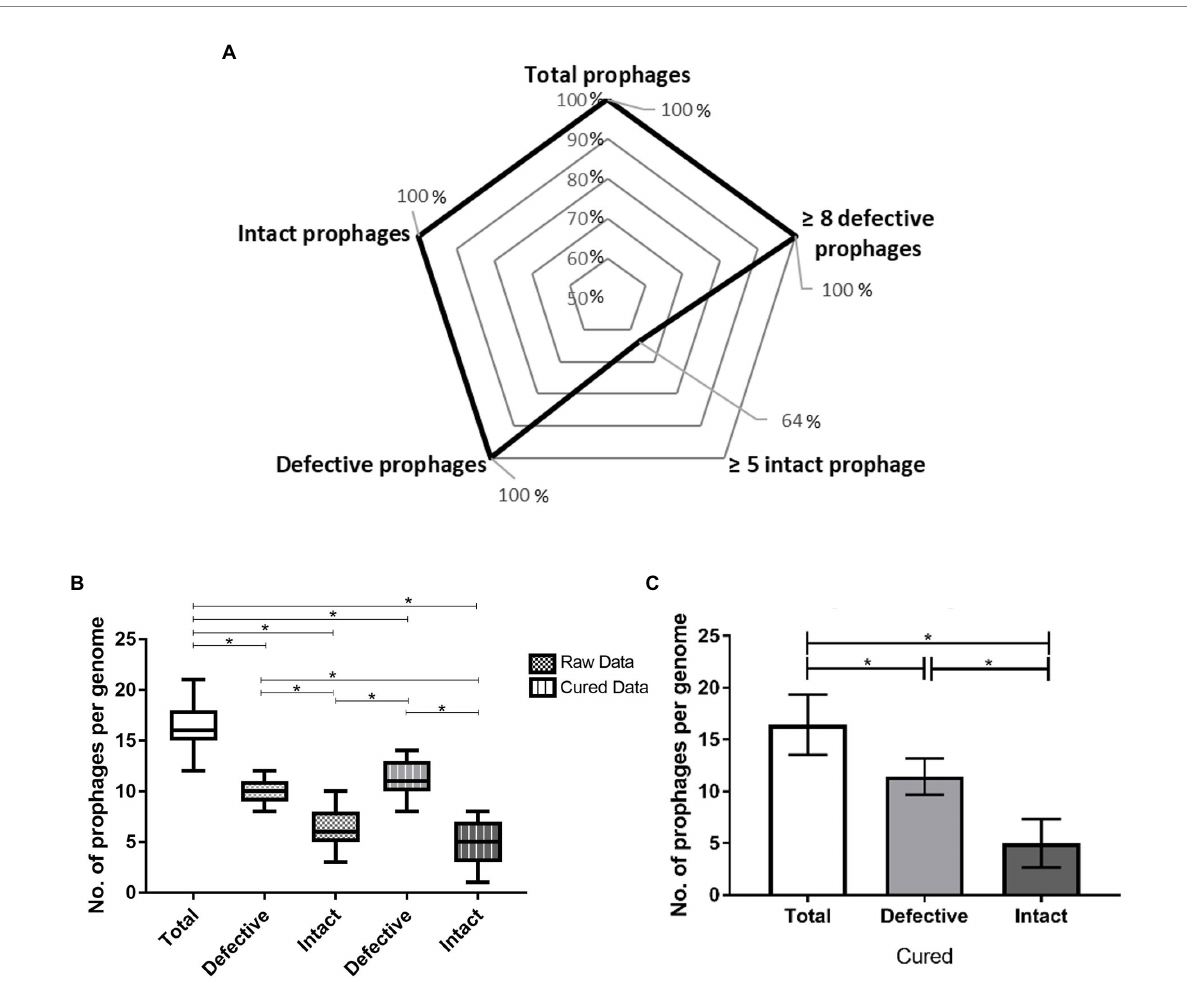
FIGURE 1 Prophage prevalence in Paenibacillus larvae genomes: (A) Percentage of hosts with ≥ one and ≥ five intact prophages and ≥ one and ≥ eight defective prophages. (B) Whisker plots of prophage frequency per bacterial genome (total, defective and intact) before and after manual curing. Raw data provided directly from PHASTER, cured data results from manual verification. The horizontal line of each box represents the average prophages per genome and the external edges to the minimum/maximum number. (C) Average of total, defective, and intact prophages present per host genome. The error bars indicate the SD. Statistically significant, if value of p < 0.05